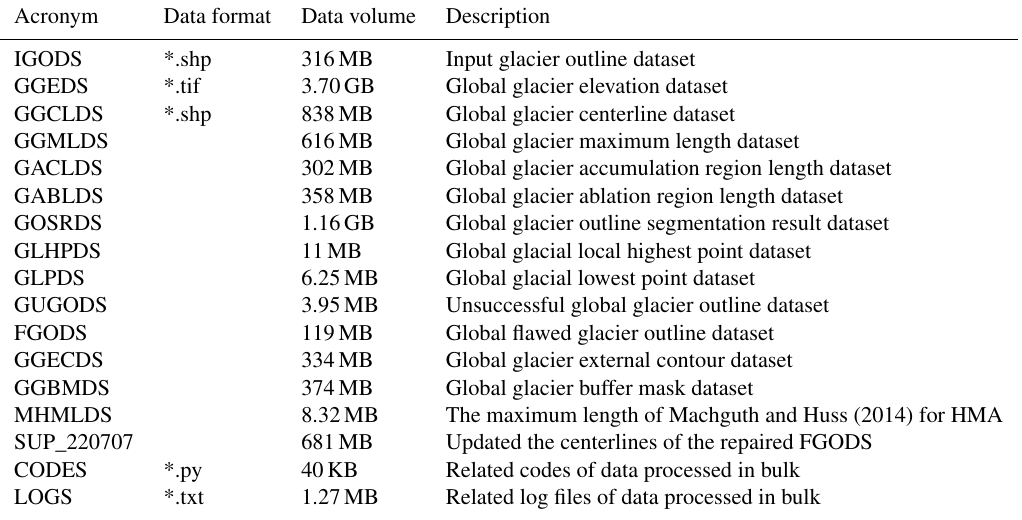
Table 5. Description of the sub-datasets contained in this